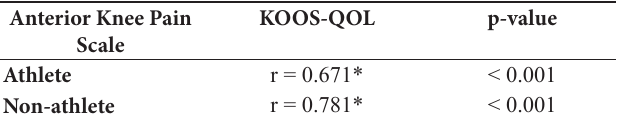
Table 3. Correlations between level of patellofemoral pain and quali- ty of life (one of the five dimensions of KOOS) in adolescent athletes and